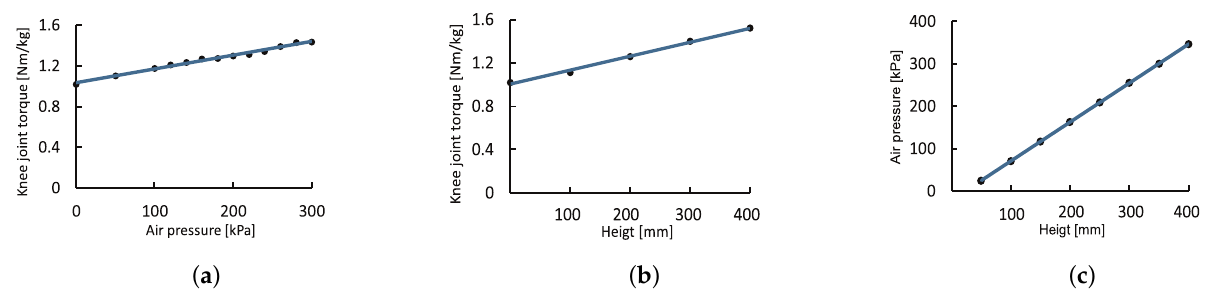
Figure 9. Analysis of peak knee-joint torque during stair-climbing while wearing the force feedback suit. Plotted are the relationships between ( a ) air pressure and maximum torque, ( b ) stair height and maximum torque, and ( c ) air pressure and stair